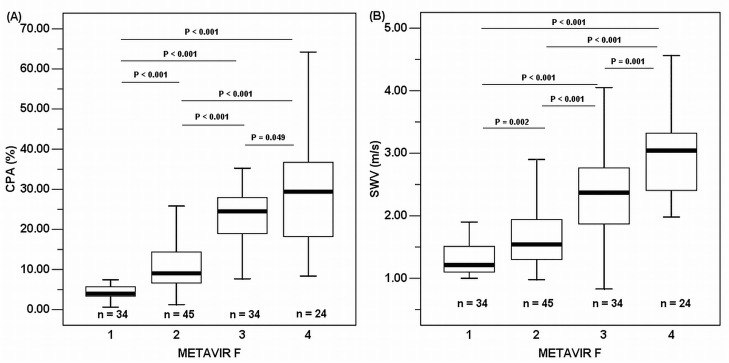
Box plots of the CPAa (A) and SWVb (B).
acollagen proportionate area; bshear wave velocity.